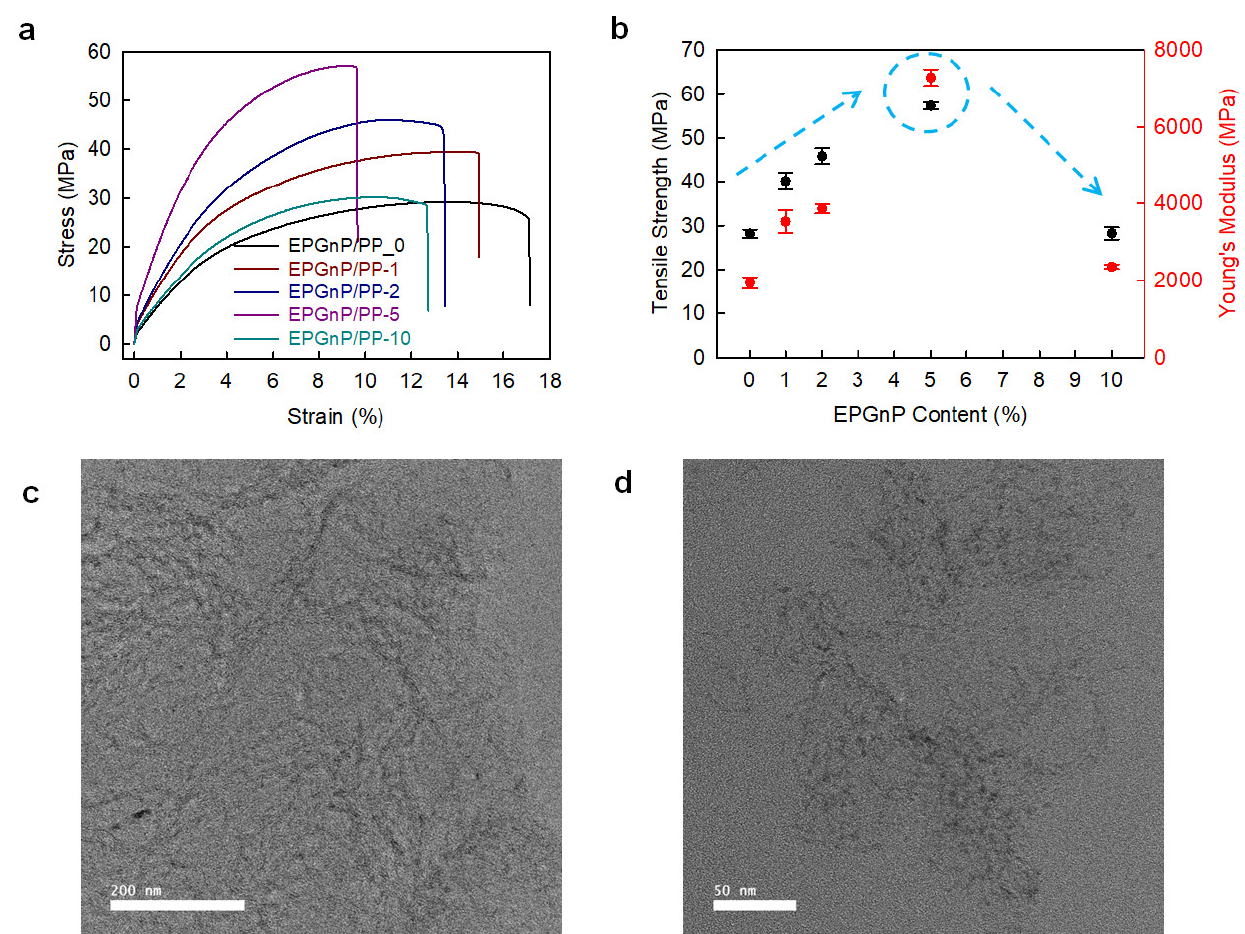
Figure 6. ( a ) S–S curves and ( b ) tensile strength and Young’s modules of EPGnP/PP_X nanocomposites. HR-TEM images of EPGnP/PP_5 nanocomposites: ( c ) low-magnification; ( d ) high-magnification. Reprinted with permission from Ref. [38]. Copyright 2021 Elsevier.